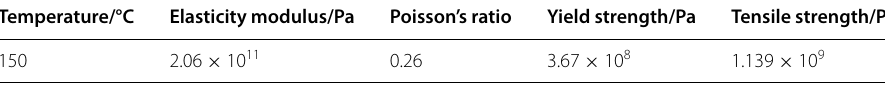
Table 2 Physical performance parameters of the expansion liner at 150 °C Temperature/°C Elasticity